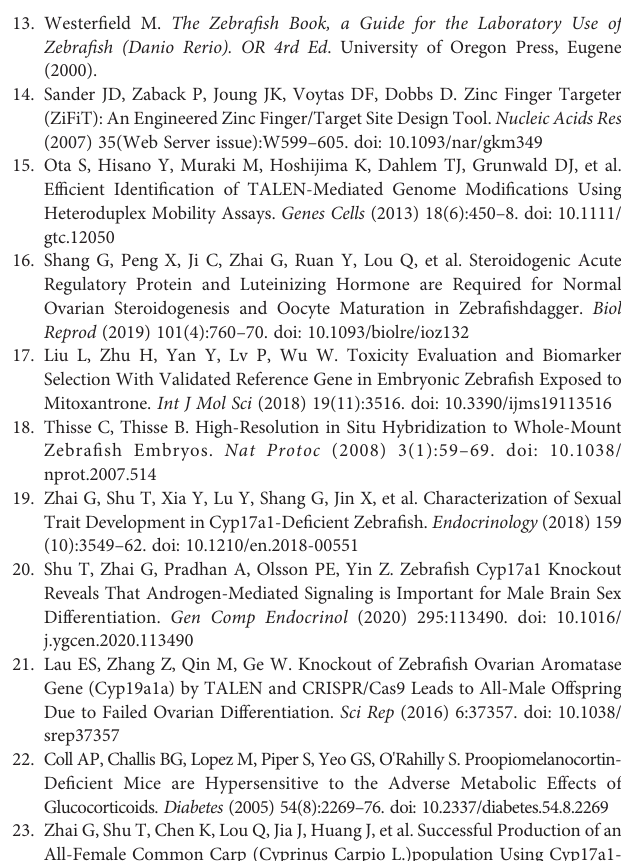
Supplementary Figure 1 | The statistical analyses of body weight and body length. (A) Body weight of cyp17a2 +/+ and cyp17a2 -/- zebra fi sh at 3 mpf (n > 10). (B) Body length of cyp17a2 +/+ and cyp17a2 -/- zebra fi sh at 3 mpf (n > 10). n.s., no signi fi cant difference. Supplementary Figure 2 | Expressions of pomca , lh b , fsh b , gh1 , prl and tsh b were analyzed with qPCR. (A, B) All mRNA levels were calculated as the fold expression relative to the housekeeping gene ef1 a . (A) Control females and cyp17a2 -/- females. (B) Control males and cyp17a2 -/- males. (C, D) All mRNA levels were calculated as the fold expression relative to the housekeeping gene gapdh . (C) Control females and cyp17a2 -/- females. (D) Control males and cyp17a2 -/- males. n.s., no signi fi cant difference. * P < 0.05. **** P < 0.0001. Supplementary Figure 3 | Phylogenetic analysis of amino acid sequences. The distance scale represents the degree of difference between sequences ( e.g. , 0.10 indicates a 10% difference between two sequences). The gene de fi nition and descriptionhavebeenprovidedafterthenameofthespecies.Thede fi nedCyp17a1 or Cyp17a2 in previous publications have been highlighted in red. Supplementary Figure 4 | Expression of cyp17a1 inovaryof cyp17a2 +/+females and cyp17a2 -/- females at 3 mpf was analyzed with qPCR. The expression level of cyp17a1 was calculated as the fold expression relative to the housekeeping gene b - actin (A) , ef1 a (B) , and gapdh (C) , respectively. n.s., no signi fi cant